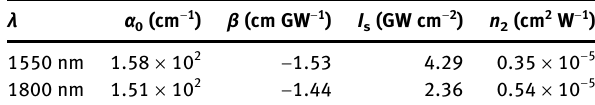
Table  : NLO performance of the GDY fi lm at different